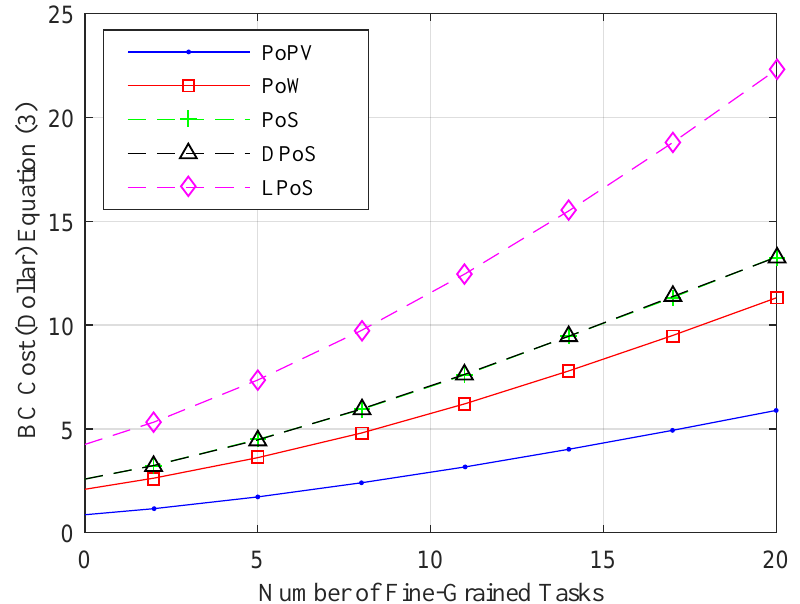
Figure 7. Proof of Validation Costs with All Healthcare Application Fine-Grained